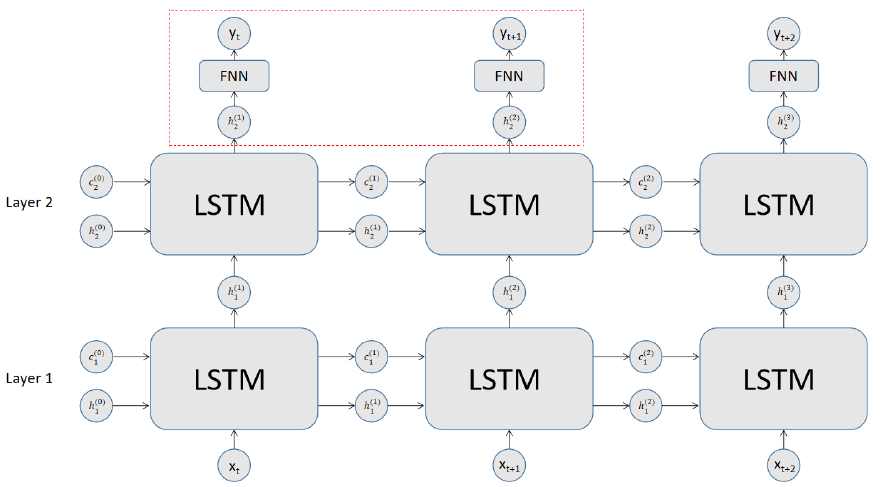
Figure 2. Schematics of an RNN cell consisting of a pair of stacked LSTM cells and a fully connected neural network at the output layer. The part in the rectangular box bounded by the dashed lines is optional.